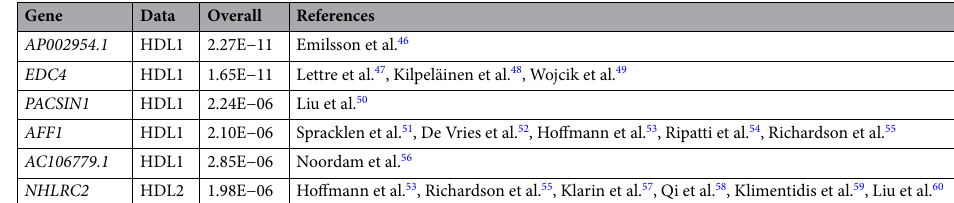
Table 6. Genes identified only by Overall based on the two lipids data sets that are reported in the GWAS